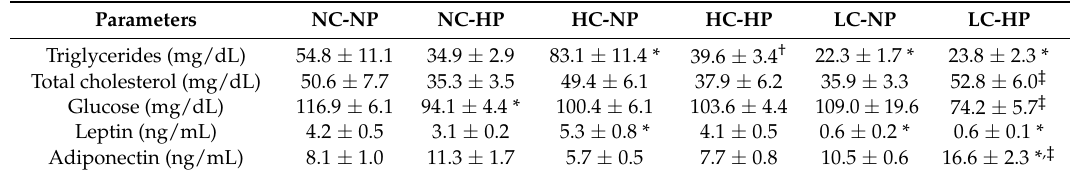
Table 1. Blood biochemistry at the end of the experiments (7 months) in rats fed diets with normal calorie-normal phosphorus (NC-NP), normal calorie-high phosphorus (NC-HP), high calorie-normal phosphorus (HC-NP), high calorie-high phosphorus (HC-HP), low calorie-normal phosphorus (LC-NP) and low calorie-high phosphorus (LC-HP). Parameters